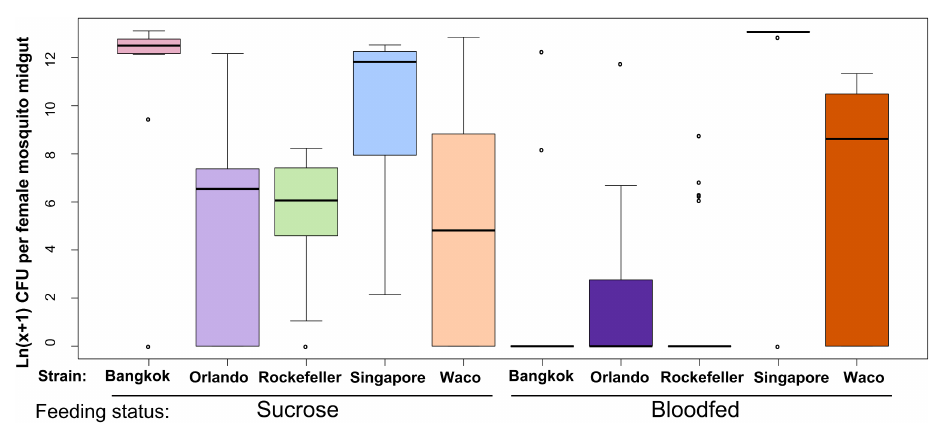
CFUs per individualfemale midgut. We collecteddata over two experimental replicates; sample sizes are as follows: Bkk sucrose : n = 13, Bkk blood : n = 11, Orl sucrose : n = 18, Orl blood : n = 24, Rock sucrose : n = 18, Rock blood : n = 25, Sing